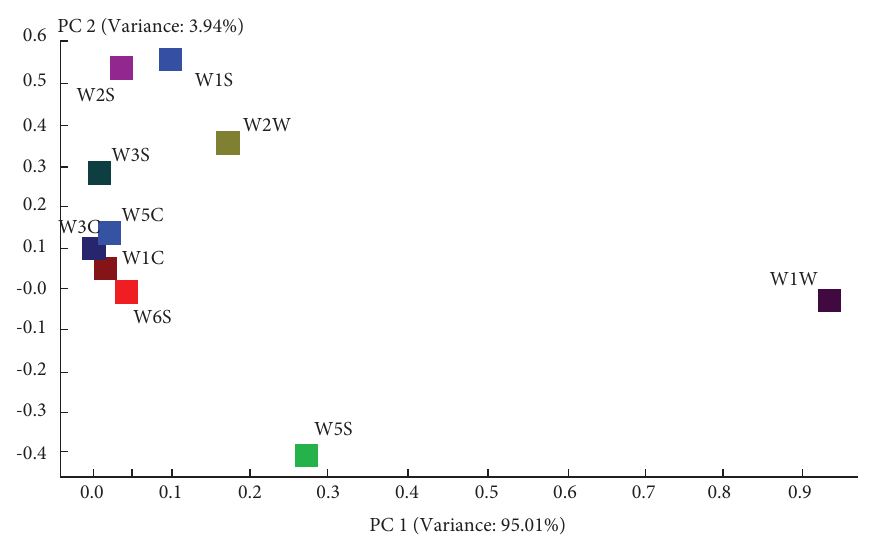
Figure 9: Loading load analysis diagram of “Yali” pear paste prepared under traditional heating and vacuum concentration